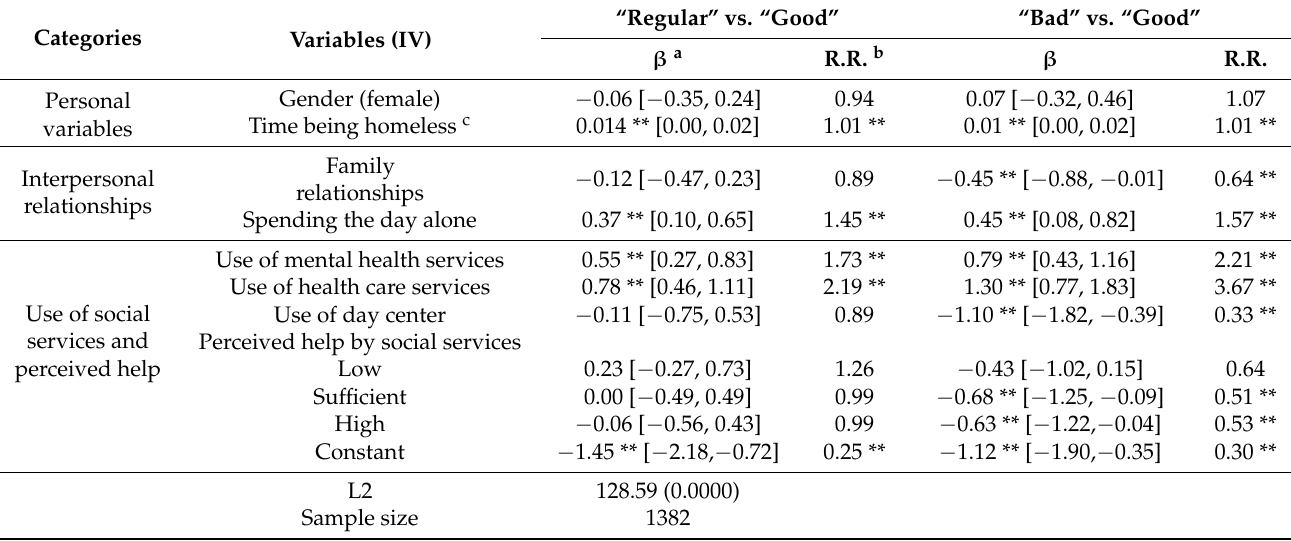
Table 3. Impact of some variables on the self-perceived health status (“good” status fixed as base